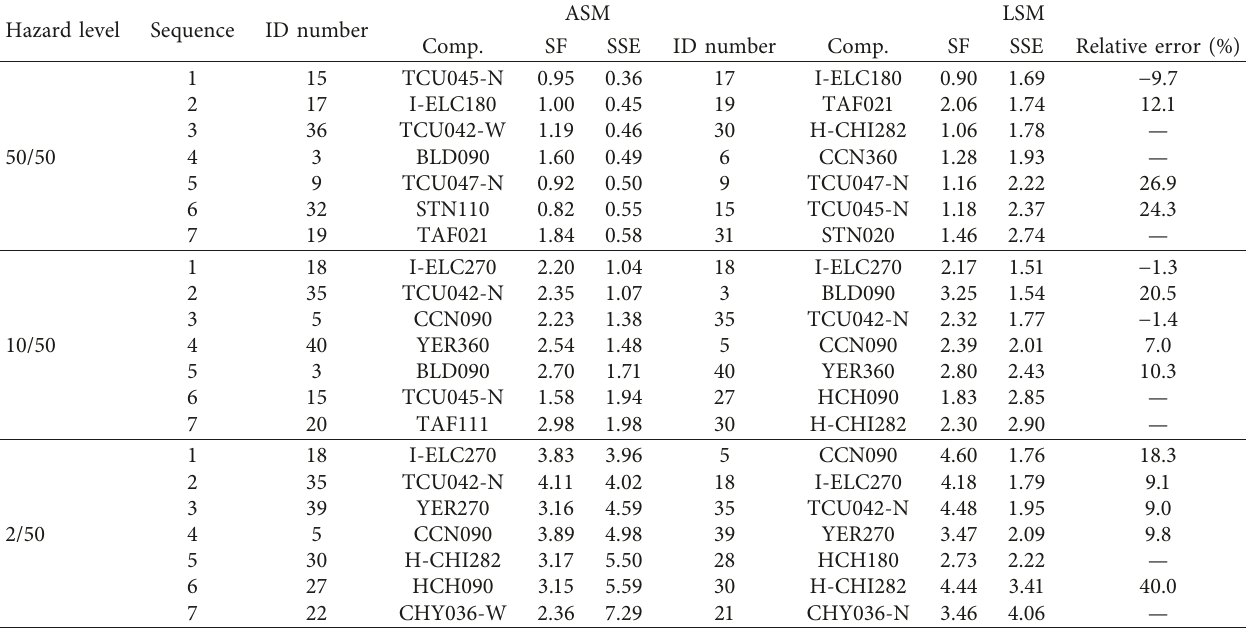
Table 4: Components selected by ASM and LSM methods at the three hazard levels (9-story). Hazard level